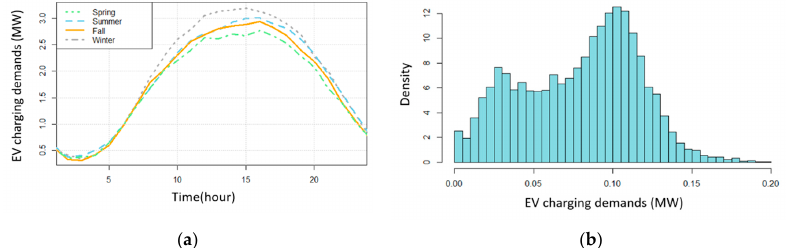
Figure 2. The EV charging demand in Jeju Island: ( a ) 24-h charging power pattern; and ( b ) the histogram of the charging power used in one year.